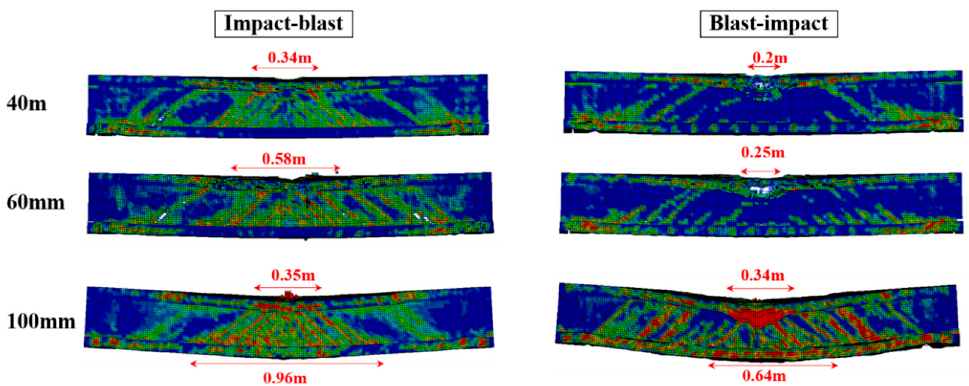
12 of 16 Figure 12. Time-history curves of mid-span displacement of beams under different beam depths. 4.4. Influences of Different Longitudinal Reinforcement Spacing By changing the longitudinal reinforcement spacing, the effect of different longitudi- nal reinforcement ratios on the damage behavior of the structure under combined load was studied. The explosion proportional distance was set to 0.32 m/kg 1/3 and the impact velocity to 6 m/s. The dynamic response and failure behavior of the structure were studied when the longitudinal reinforcement spacing of I-shaped RC beams was 40 m, 60 mm and 100 mm, respectively. Figure 13 shows the damage states of the beams under combined loads of different longitudinal reinforcement spacing. Figure 14 shows the time-history